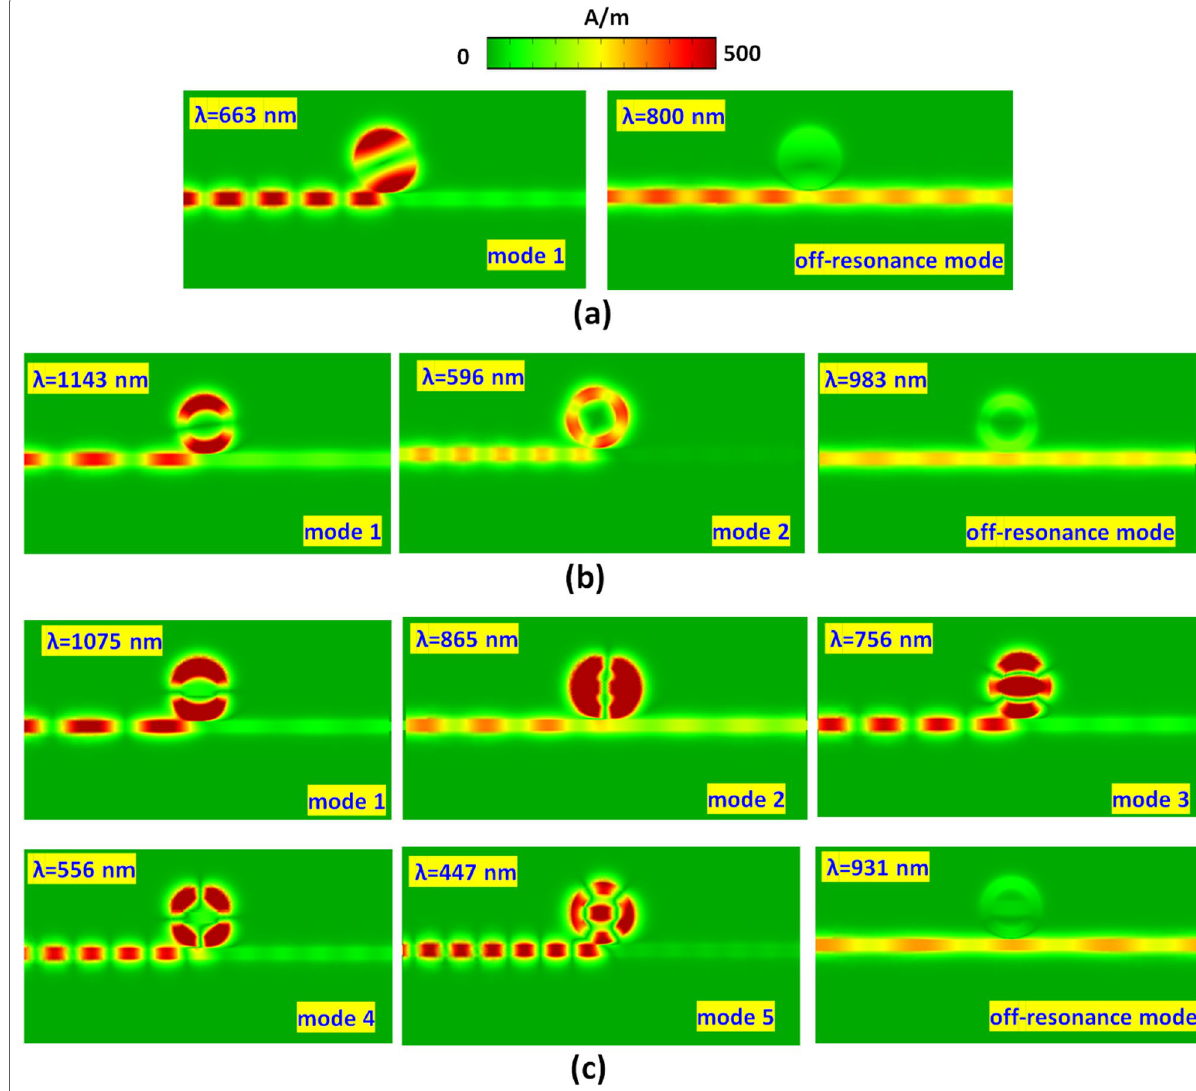
Fig. 3 Truncate views of magnetic field intensity (|H|) at the corresponding wavelengths of resonance modes and off‑resonance modes in a case 1, b case 2, and c case 3,